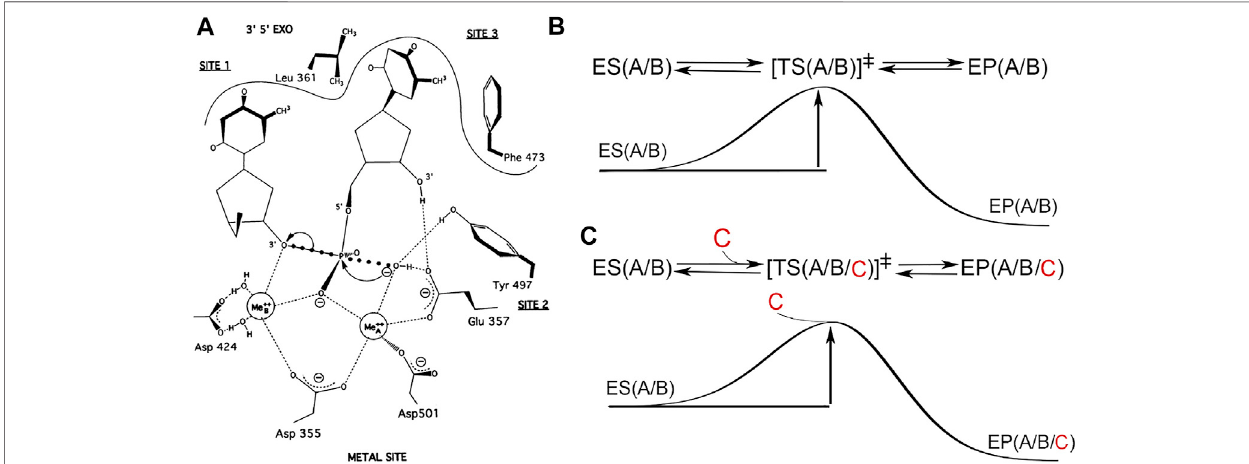
FIGURE 1 | Two-metal-ion catalytic mechanism or three metal ions? (A) Hypothetical transition state for the hydrolysis of phosphodiester bond in the 3 ′ ,5 ′ - exonuclease active site of Klenow fragment (adapted from Steitz and Steitz, 1993, with permission, ©National Academy of Sciences, 1993). (B) Free energy diagram of theclassicTStheoryinvolvingtwometalionsAandB,whichareintrisicpartsofbothESandEPcomplexesandremainunchangedduringcatalysis.Simultaneousbond- breakingandbond-formationatthetransitionstateisazeroorderreaction. (C) Hypothetical3-metalioncatalyticmechanismwiththethirdmetalionCenteringnear or at the TS point, which is not compatabile with the classic TS theory. In this hypothesis, simultaneous bond-breaking and bond formation is a fi rst order reaction, dependentontheoccupancyofthethirddivalentmetalion.Thishypothesispredictsacomplexdependenceofthepolactivityontheconcentrationofdivalentmetalions invovling all three sites, which has never been supported by any biochemical data (see text).